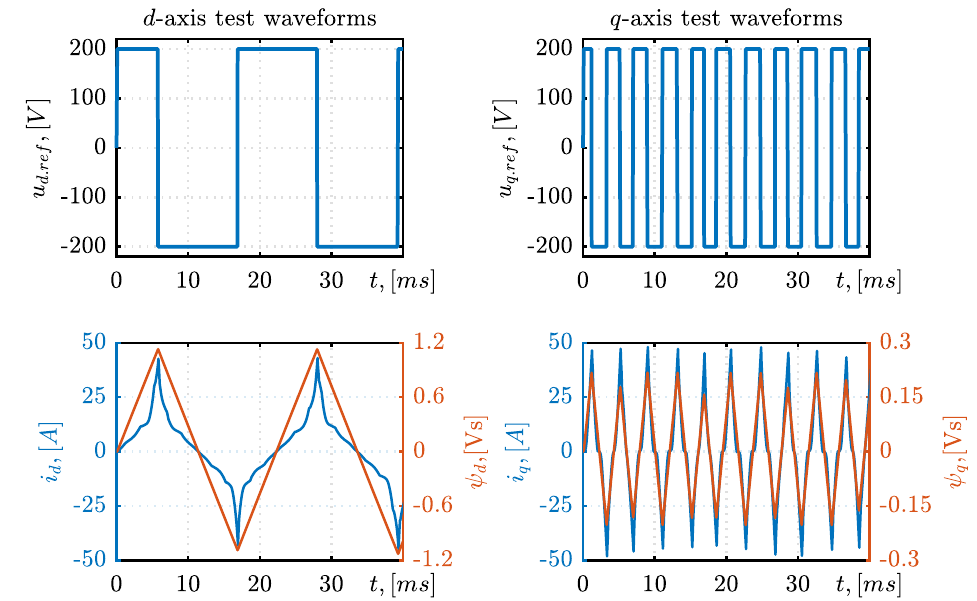
Figure 17. Waveforms of the cross-saturation test, both axes are excited